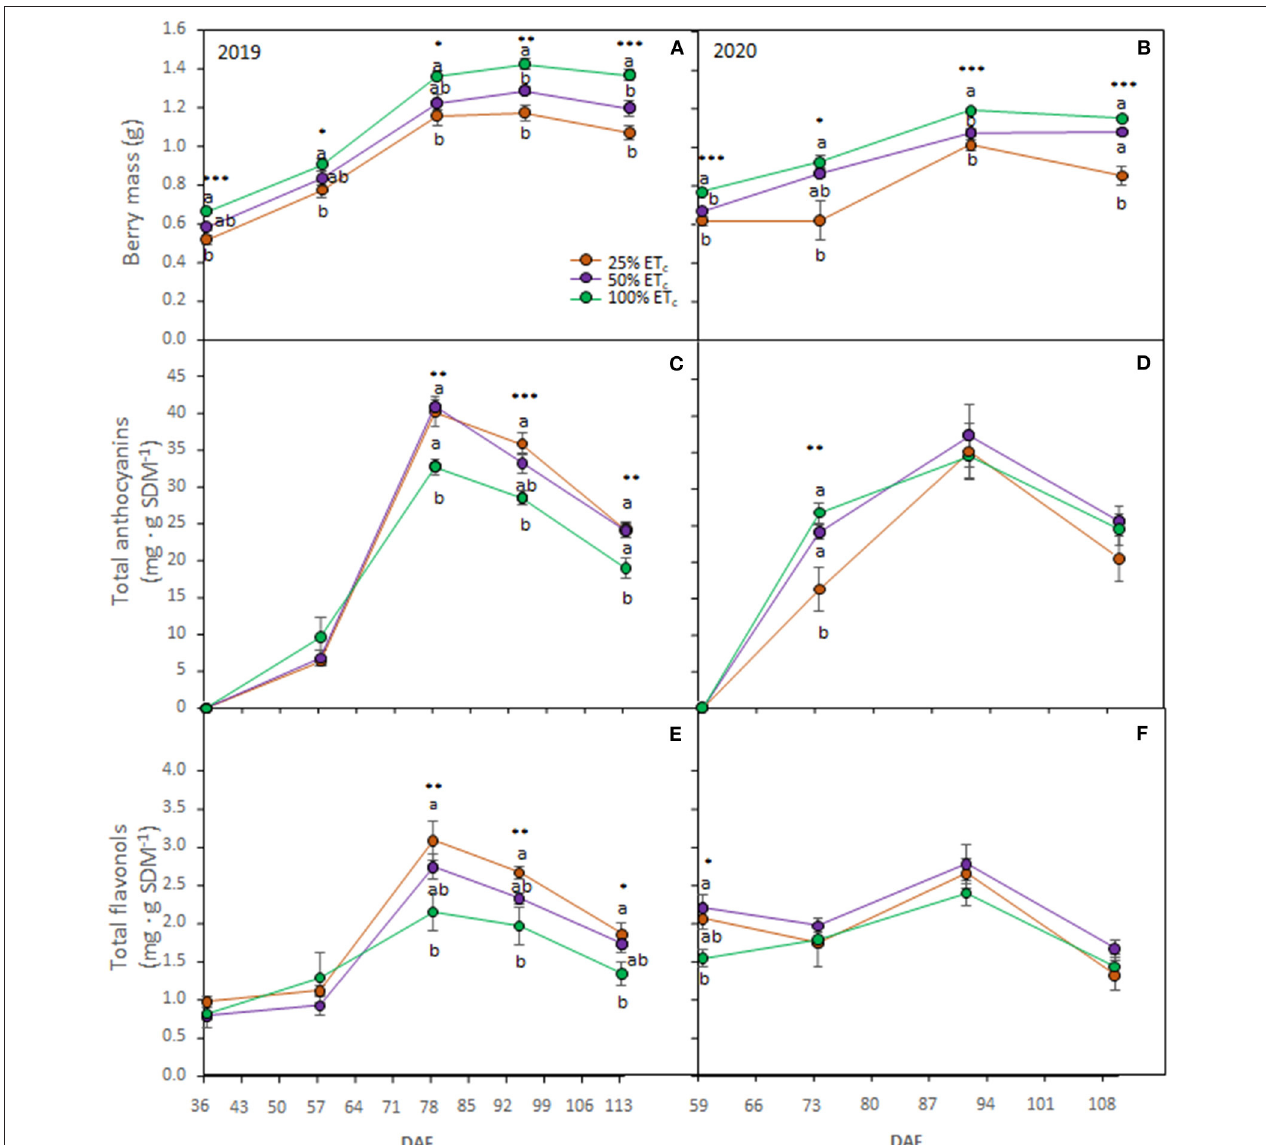
FIGURE 3 | Berry mass ( A, B ), total anthocyanins ( C, D ), and total flavonols ( E, F ) in berry skin dry mass (SDM) of Cabernet Sauvignon grapevines (clone FPS08), subjected to different replacements of crop evapotranspiration (25, 50, and 100% ET c ) and collected through 2018–2019 and 2019–2020 growing seasons in Oakville, CA. Values represent means ± SE ( n = 6). At each time point, different letters indicate significant differences ( p ≤ 0.05) between irrigation treatments according to one-way ANOVA followed by Tukey HSD test. *, **, and *** indicate significance at 5, 1, and 0.1% probability levels, respectively. DAF, Days after flowering.